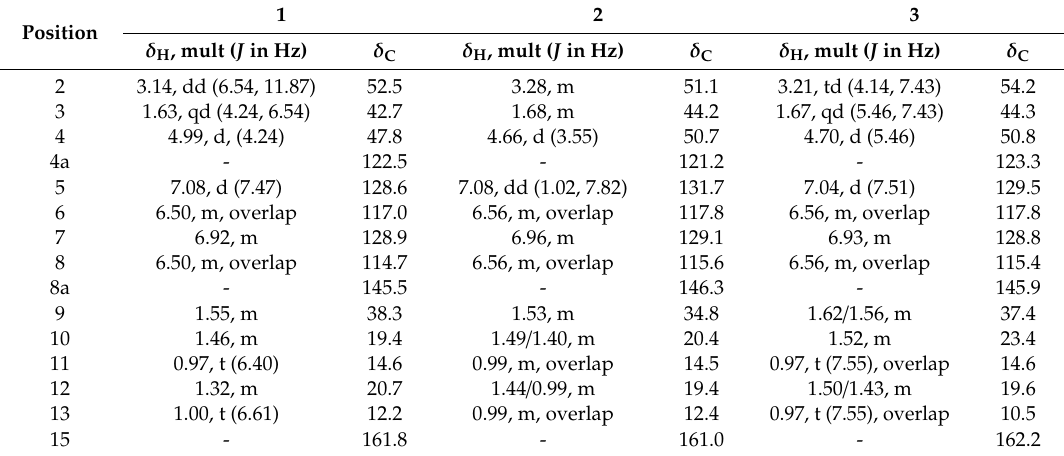
Table 1. 1 H and 13 C NMR spectroscopic data for compounds 1 – 3 (600 MHz, methanol- d 4 ).